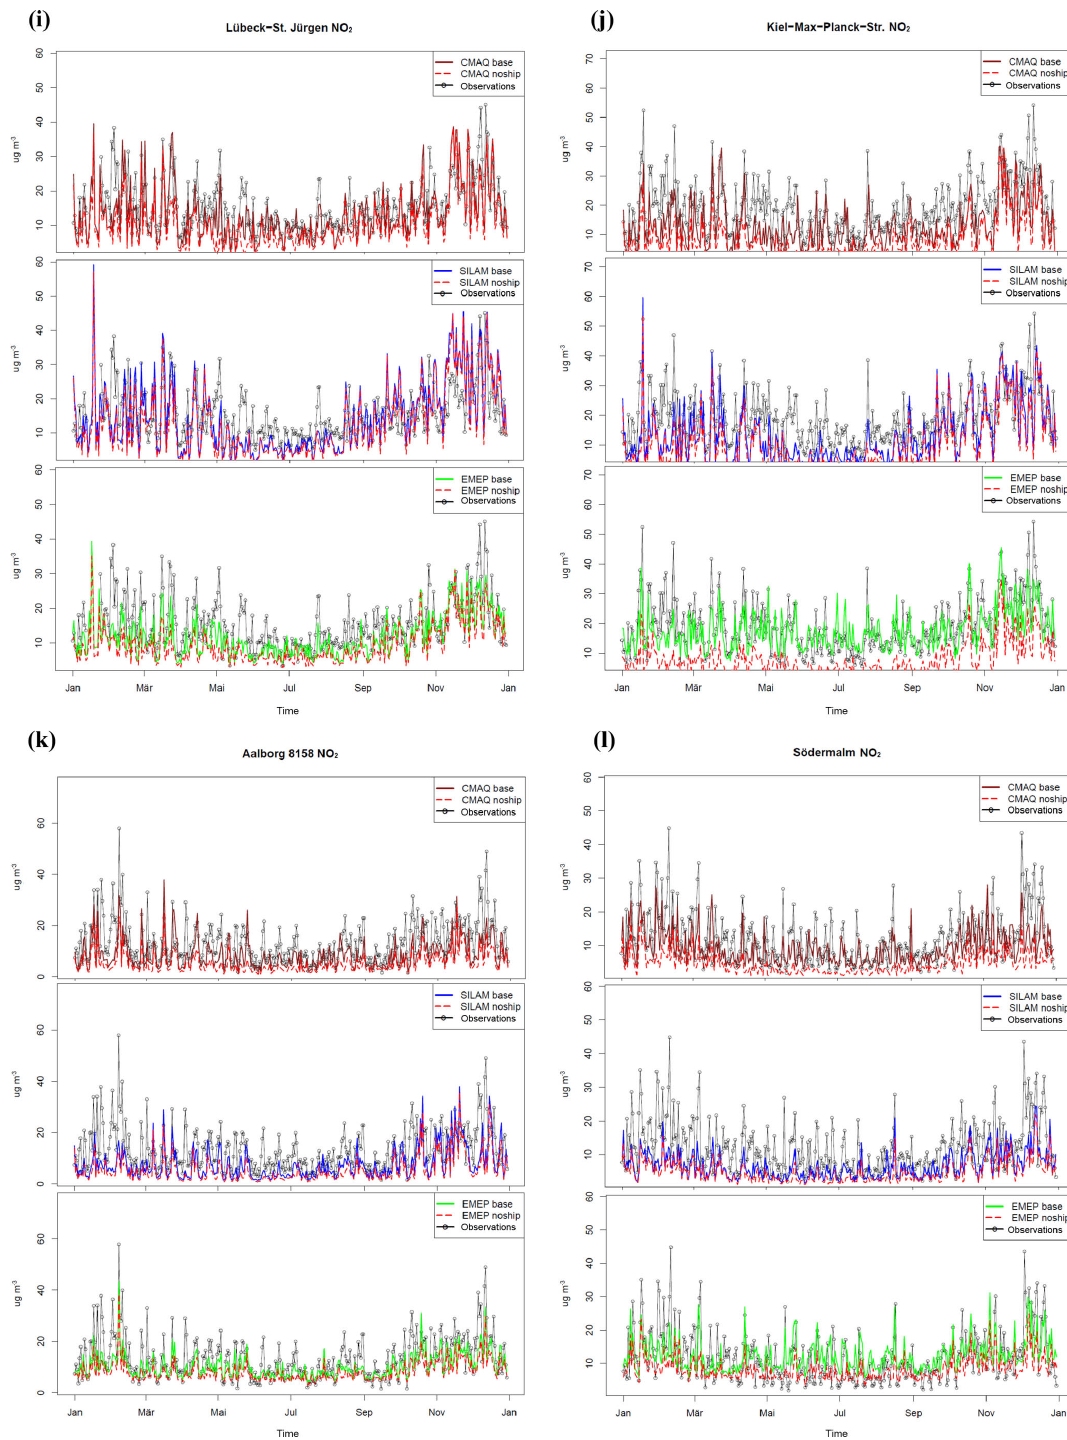
Figure B1. Ship influence on daily mean NO 2 concentration (µgm − 3 ): (a) EE0011A, (b) FI00349, (c) SE0066A, (d) DESH023, (e) FI00351, (f) EE0009R, (g) PL0053A, (h) PL0171A, (i) DEMV021, (j) DESH033, (k) DK0053A, and (l) SE0022A. Model data from CMAQ (dark red line), SILAM (blue line), EMEP/MSC-W (green line), the respective noship run (dashed red line) and observations (black line with open